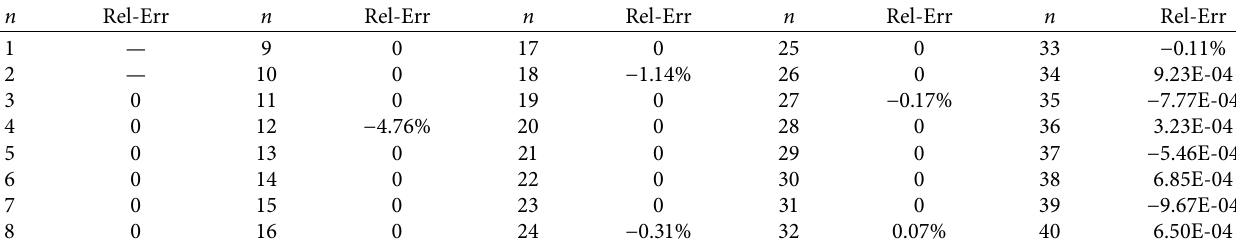
( n ) to h ( n ) when n ≤ g 0 ′